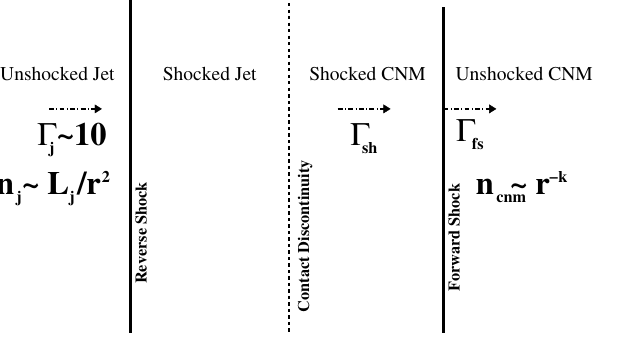
Figure 2. Lorentz factor of the shocked circumnuclear medium (CNM) behind the forward shock ( Γ sh ; thick solid red line), of the contact discontinuity (dashed brown line) and of the shocked jet (dotted blue line), extracted directly from a one-dimensional hydrodynamic simulation (Mimica et al. 2009). The calculation is performed assuming a jet duration t j = 3 × 10 5 s, initial jet luminosity L j , 0 = 10 48 ergss − 1 and CNM radial density profile n cnm = 10( r / 10 18 cm) − 1 cm − 3 ( k = 1). Shown for comparison with black solid lines are the analytic approximations for Γ sh during the early phase when the reverse shock is crossing through the shell of ejecta released during the initial period of constant jet luminosity ( t (cid:1) t j ), and at late times during the Blandford-McKee self-similar evolution ( t (cid:5) 2 t j ) for di ff erent assumptions about the total energy of the blast wave E j , iso . Note that a break occurs in the Lorentz factor of the shocked jet once the outflow reaches the radius r = r cross ≈ 3 × 10 17 cm (observer time t ≈ t j ) at which the reverse shock has crossed entirely through the initial shell. The break in Γ sh from this transition occurs at a somewhat larger radius r ≈ 7 × 10 17 cm ( t ≈ 2 t j ), once the rarefaction wave launched at r ≈ r cross reaches the forward shock (from MGM12).